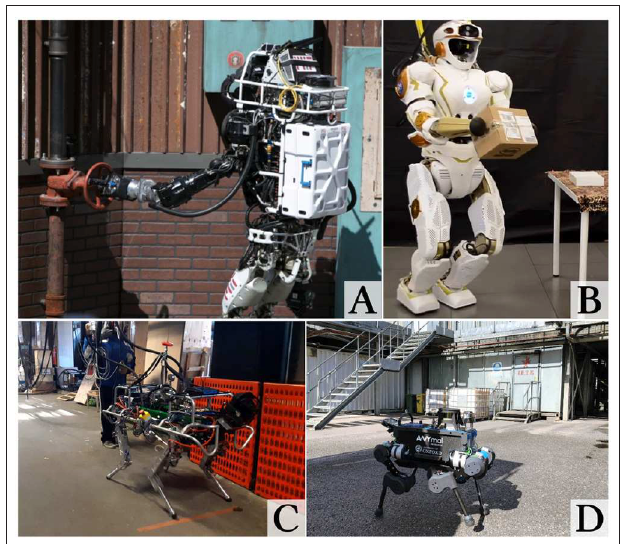
FIGURE 1 | The Atlas (A) and Valkyrie (B) humanoid robots and the HyQ (C) and ANYmal (D) dynamic quadruped robots. Sources: MIT, University of Edinburgh, Istituto Italiano di Tecnologia (IIT), University of